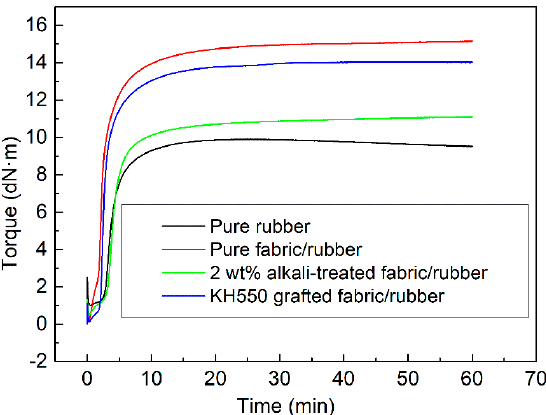
Figure 7. Weight loss as a function of time for pristine fabric, NaOH-treated fabric, KH550-grafted fabric.